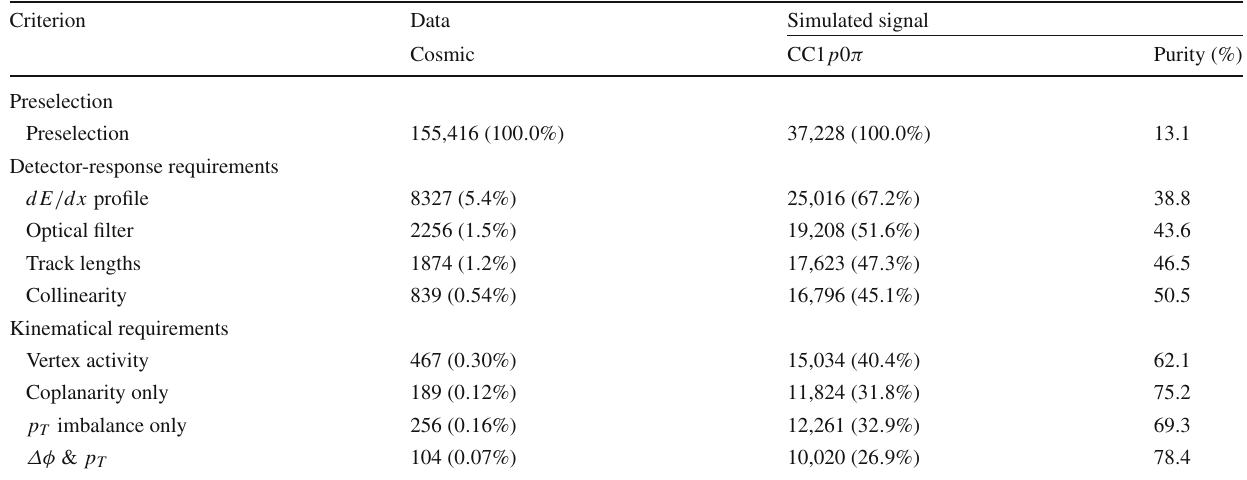
Table 1 Application of the detector observable and kinematic selec- tion criteria on close-proximity tracks contained in the detector fiducial volume. The requirements in the first five rows are made on variables insensitivetotheneutrinointeractionmodel(seeSect.3),andinthefour last rows are the kinematic selection criteria (see Sect. 4). The numbers in parentheses are the fractions of the original studied samples retained